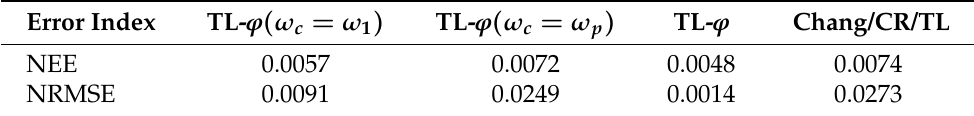
Figure 7. Displacement responses for m 50 . ( a ) ˜ ω = 1 rad/s. ( b ) ˜ ω = 6 rad/s. ( c ) ˜ ω = 16 rad/s. ( d ) ˜ ω = 40 rad/s. Table 6. Displacement errors for m 50 ( ˜ ω = 1 rad/s,